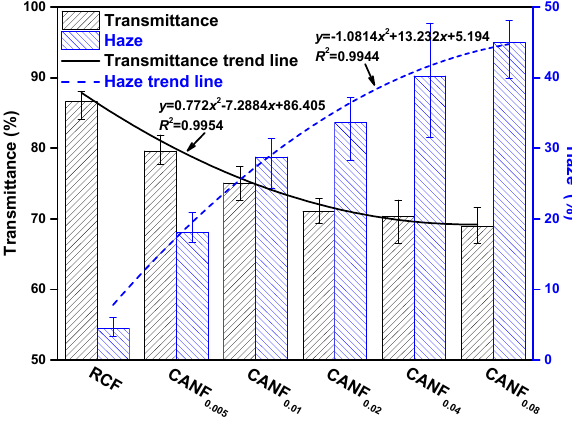
Figure 7. Transmittance and haze histogram of composite films.